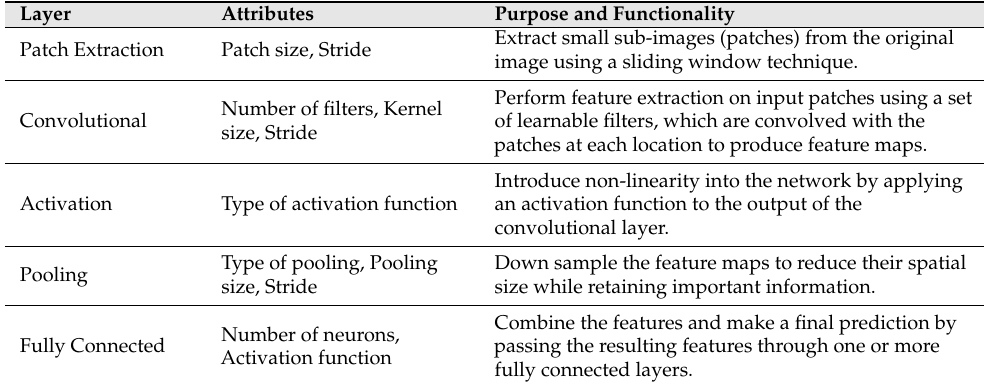
Table 7. Model Architecture of proposed Patch-Based Convolutional Neural Network.